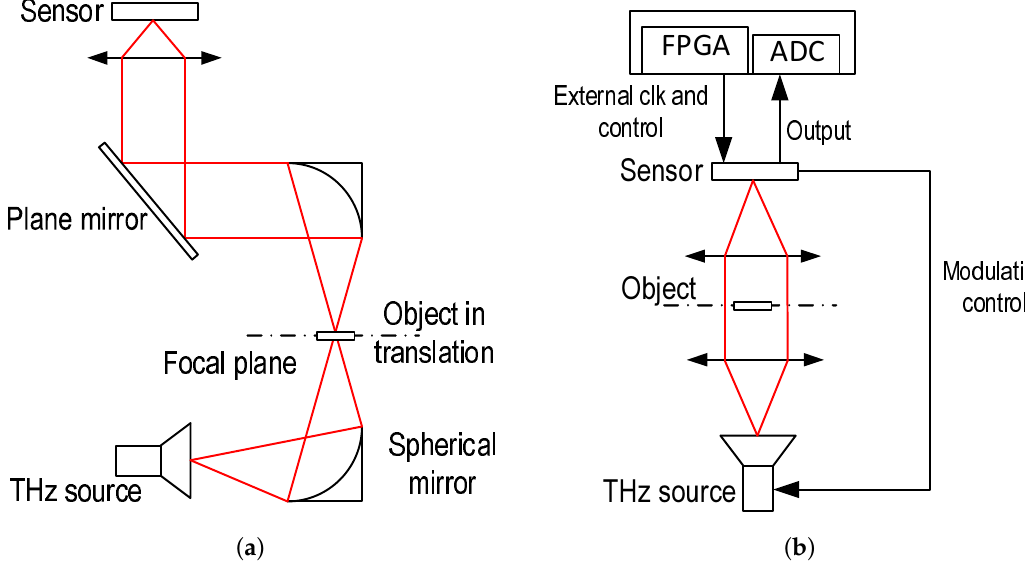
Figure 12. Experimental setup used with ( a ) the 2.5 THz laser gas source; and ( b ) with the multiplying chain sources in the range [ 200 : 600 ]